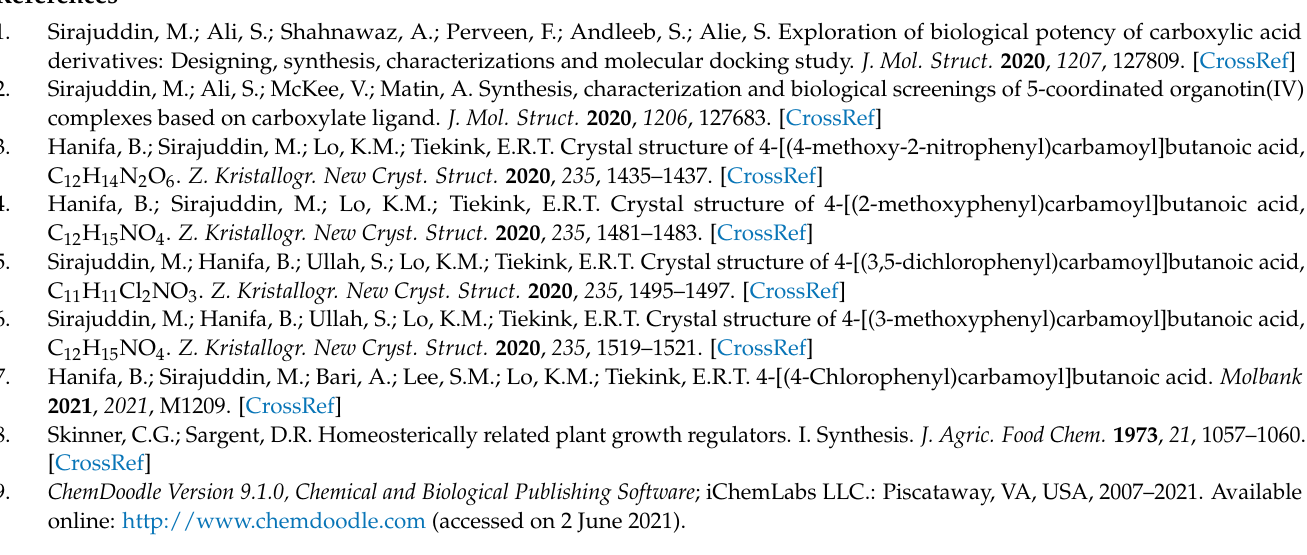
Figure S6: UV spectrum of 4-[(2,4-dichlorophenyl)carbamoyl]butanoic acid ( 1 ), Figure S7: The